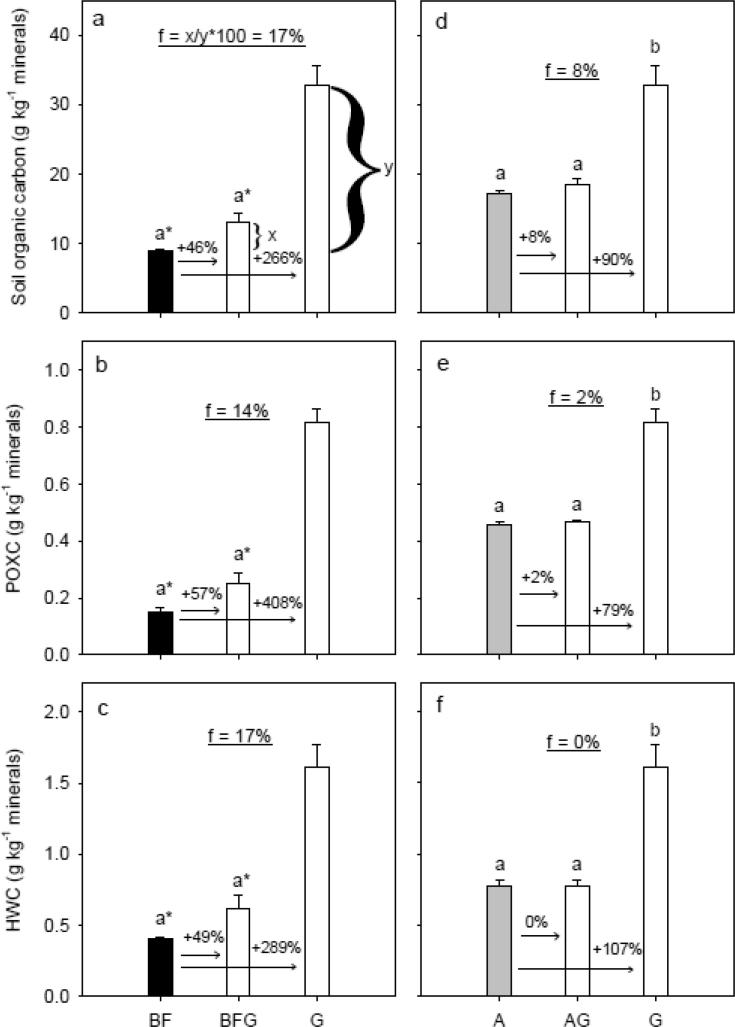
Restoration scenarios: Management system effects on soil organic carbon, permanganate oxidizable carbon (POXC), and hot water-extractable carbon (HWC). White, gray and black bar fills highlight treatments grass, arable and bare fallow, respectively, at time of sampling. Letters denote statistical significance at P < 0.05. An asterisk (*) indicates if G is significantly different from BF and BFG based on a pairwise t-test. The numbers above the arrows denote relative differences. The underlined number in the middle part of the figures denotes the increase after six years in relation to the long-term increase, and an example of the calculation is shown in Fig. a. For treatment abbreviations, see Fig. 1.